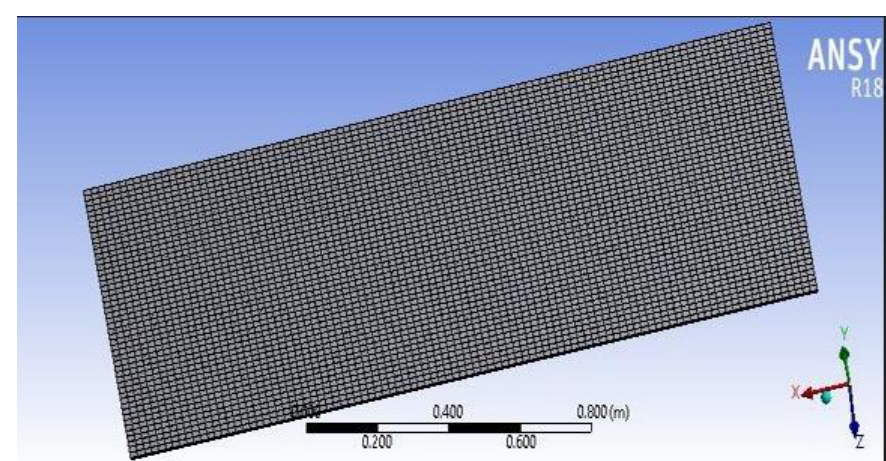
Figure 9. CAD model of PV panel.